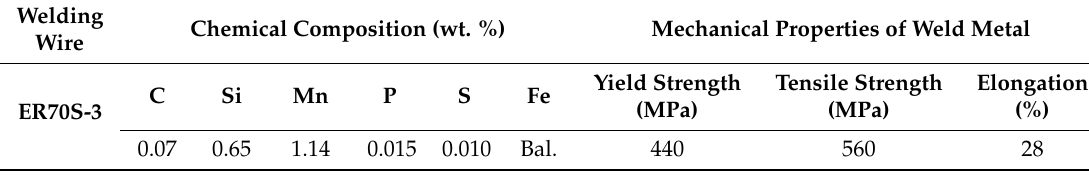
Table 2. Chemical composition and mechanical properties of the filler wire.